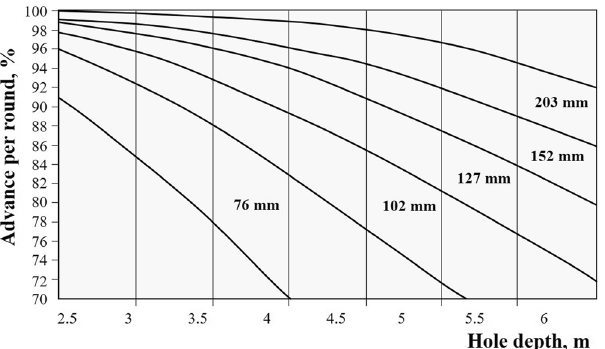
Figure 4. The relationship between hole depth and advance for different empty hole diameters 10